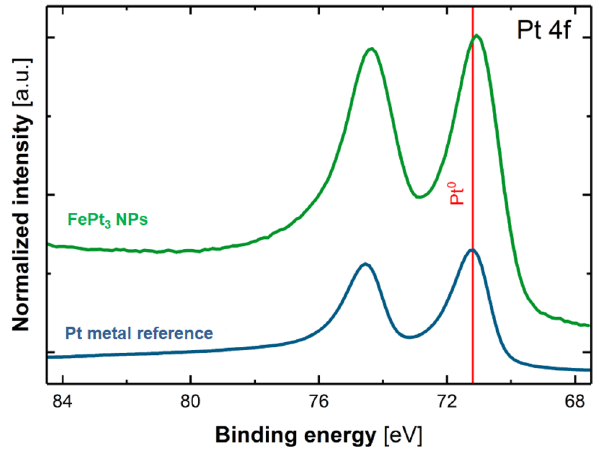
Fig. 7 Pt 4 f XPS spectrum of the FePt